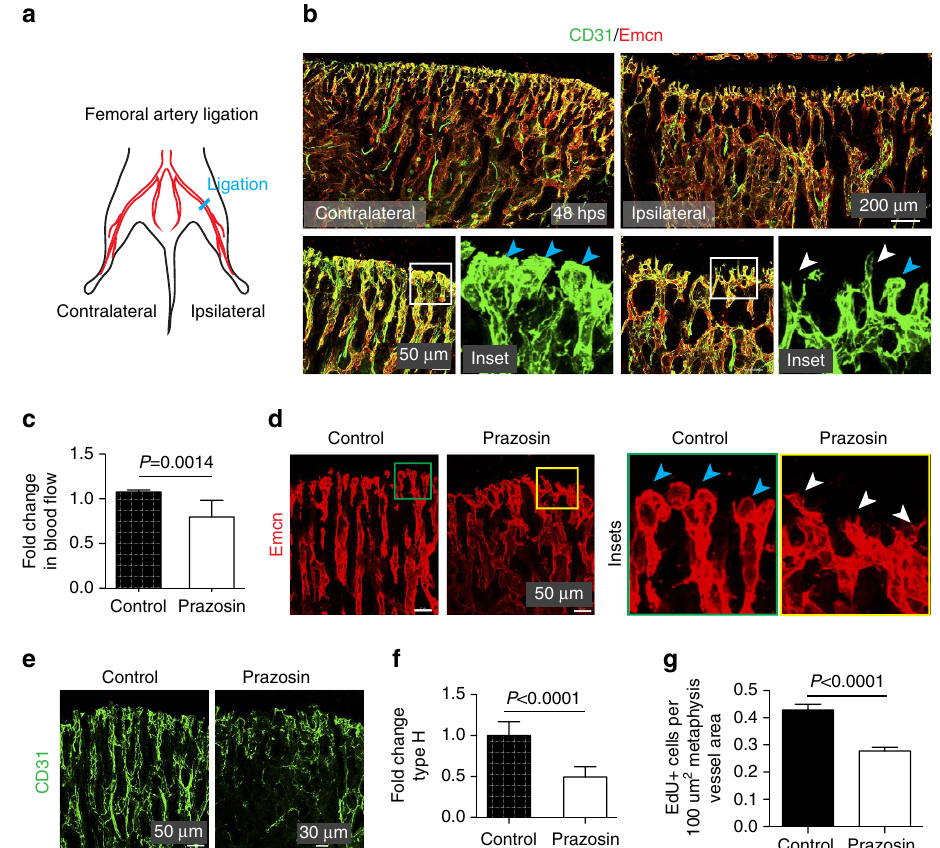
Figure 2 | Changes in blood flow impair bone angiogenesis. ( a ) Schematic representation of unilateral femoral artery ligation in 3-week-old mice. Results compare operated (ipsilateral) legs with contralateral controls. ( b ) Representative confocal images showing CD31 (green) and Emcn (red) immunostaining of tibia from ligated and contralateral side at 48h post surgery (hps). Note decline in vascular front structures, buds and columns on ligation. Insets show vessel buds (blue arrowheads) on the contralateral side and appearance of pointed, sprout-like structures (white arrowheads) after ligation. ( c ) Analysis of blood flow in Prazosin-treated tibia compared with saline-treated control. Data represent mean ± s.d. ( n ¼ 4 biological replicates). P values, two-tailed unpaired t test. ( d , e ) Confocal images of 4-week-old Prazosin-treated and control tibial metaphysis immunostained for Emcn (red; d ) or CD31 (green; e ). Insets in d show vessel buds (blue arrowheads), which appeared collapsed (white arrowheads) after Prazosin treatment. CD31 (green) expression was decreased in Prazosin-treated animals ( e ). ( f ) Flow cytometric quantification of tibial type H ECs after treatment with Prazosin or control (saline). ( g ) Quantitation of EdU þ ECs present in the metaphysis of Prazosin-treated and control mice. Data represent mean ± s.e.m. ( n ¼ 4 biological replicates). P values, two-tailed unpaired t